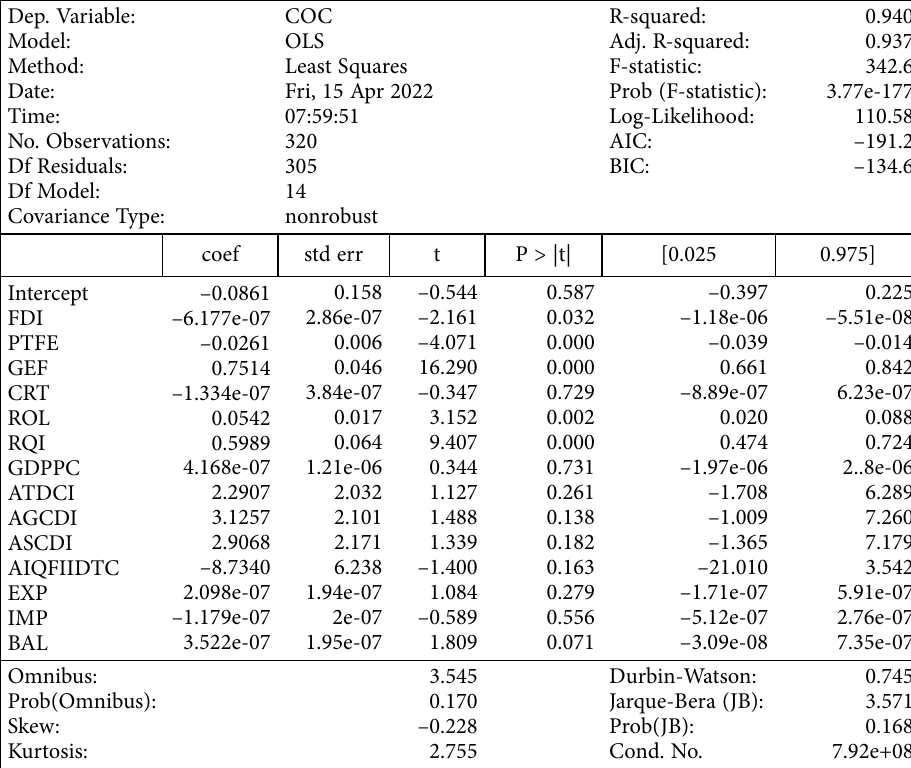
Table 6. OLS regression results – Part 2 (source: own processing using Python 3.0